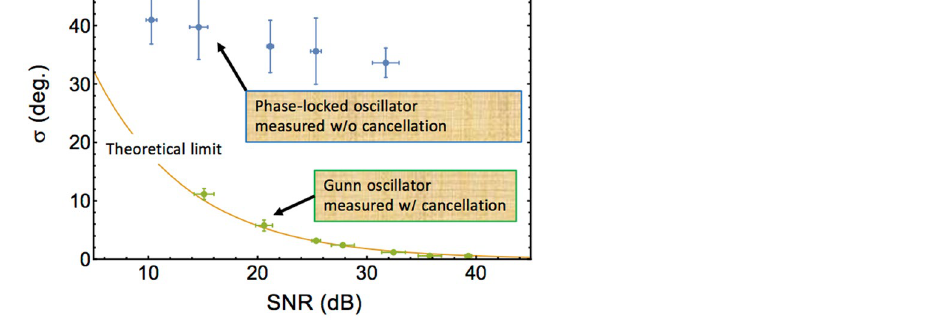
Figure 3. Relationship between the phase standard deviation and the amplitude